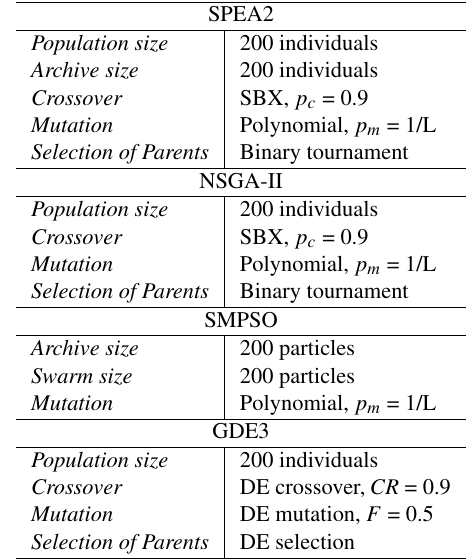
Table 1. Parameters. L = 18 (size of individuals). The termina- tion condition is performing 300 iterations.